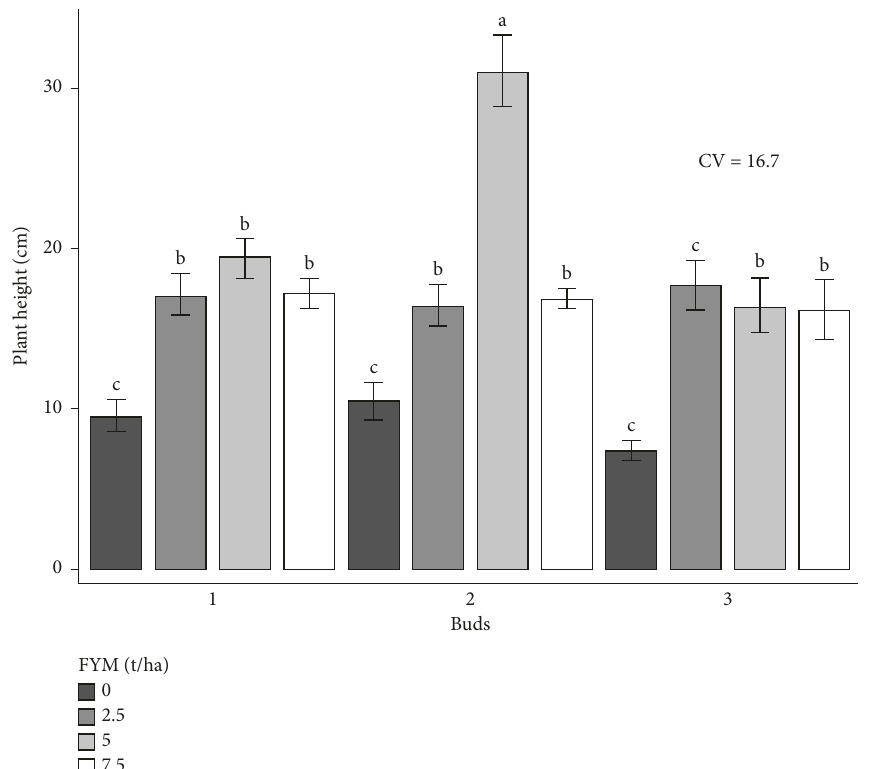
Figure 2: Plant height as influenced by the interaction effect of bud numbers and farmyard manure fertilizer